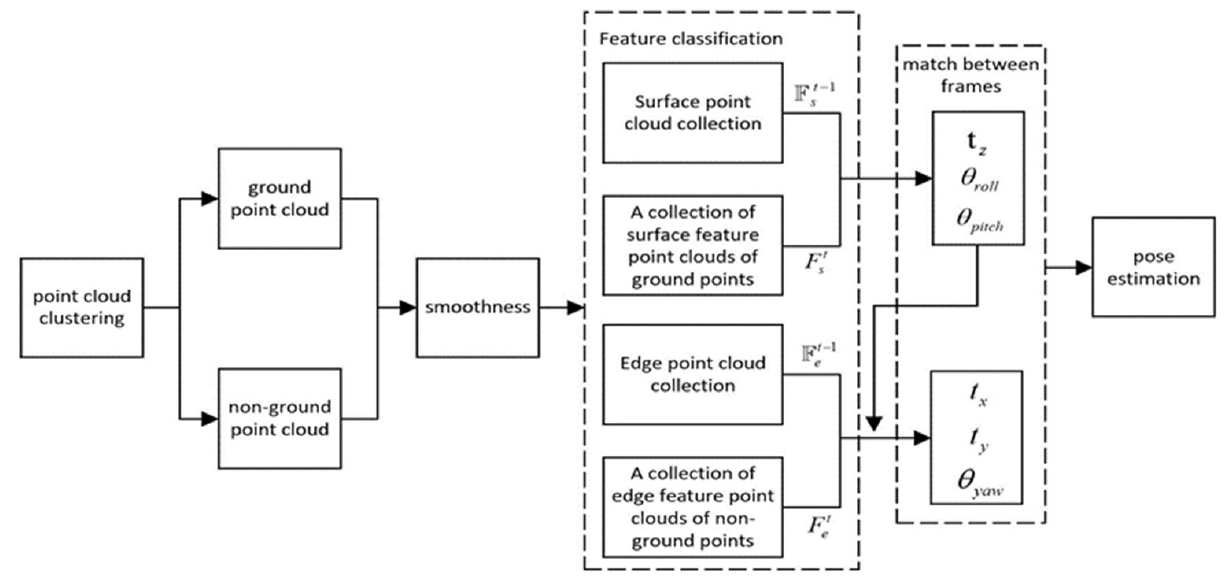
Figure 8. The point cloud pose estimation.